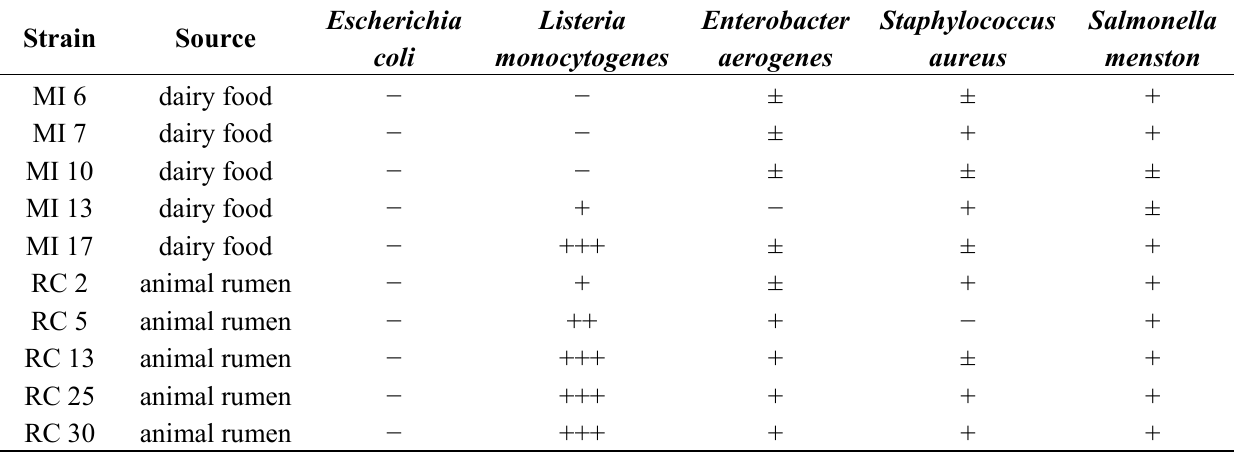
dairy food − +++ ± ± + RC 2 animal rumen − + ± + + RC 5 animal rumen − ++ + − + RC 13 animal rumen − +++ + ± + RC 25 animal rumen − +++ + + + RC 30 animal rumen − +++ +